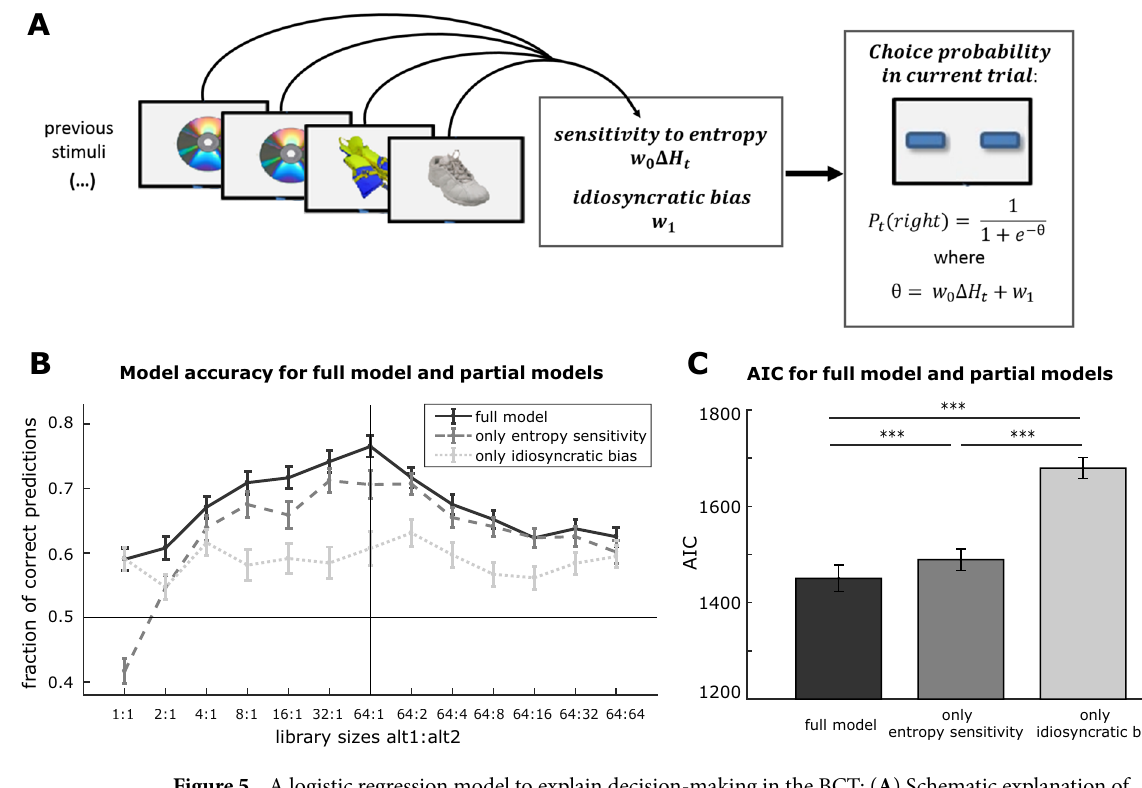
Figure 5. A logistic regression model to explain decision-making in the BCT: ( A ) Schematic explanation of the model and how its parameters are derived from participants’ experience: (i) sensitivity to entropy describes how strongly the experienced entropy difference impacts the consecutive choice, and (ii) idiosyncratic bias describes a general bias for one alternative. Images are examples from the visual stimulus libraries taken from the Bank of Standardized Stimuli 59,60 . ( B ) Average fraction choices that are correctly predicted by the model over the different BCT conditions, where three models are independently fit to the choice data and their predictions are compared (each line presents the average over n = 148 participants, vertical bars indicate the standard error of the mean): (i) the full model with two parameters, (ii) a partial model with only sensitivity to entropy and (iii) a partial model with only idiosyncratic bias . The accuracy of the full model is found to strongly depend on the parameter of entropy sensitivity, where this parameter increases its predictive power as the difference between both alternatives is raised. The idiosyncratic bias on the other hand has a smaller impact on choice predictions that is widely independent from the stimulus libraries of the task. ( C ) Comparison of the model goodness measured as Akaike’s Information Criterion (AIC) between the full regression model and partial models with only one parameter (each bar spans the data from n = 148 participants, vertical bars indicate the standard error of the mean). Smaller AIC values indicates a better model. All partial models (only entropy sensitivity and only idiosyncratic bias) show a decreased goodness of fit in comparison to the full model (***: one-tailed Wilcoxon signed rank tests with p < 0.001). Furthermore, the model with only entropy sensitivity performs better than the model with only idiosyncratic bias (***: one-tailed Wilcoxon signed rank test with p < 0.001), indicating that entropy sensitivity is an important determinant of the following choice probability in the